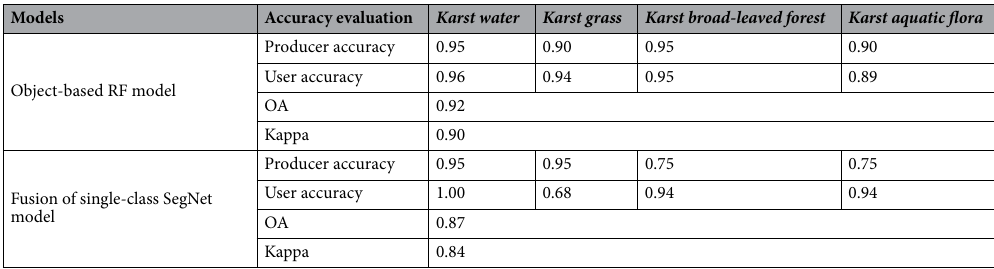
Table 7. Comparison of classification accuracies between object-based RF and fusion of single-class SegNet